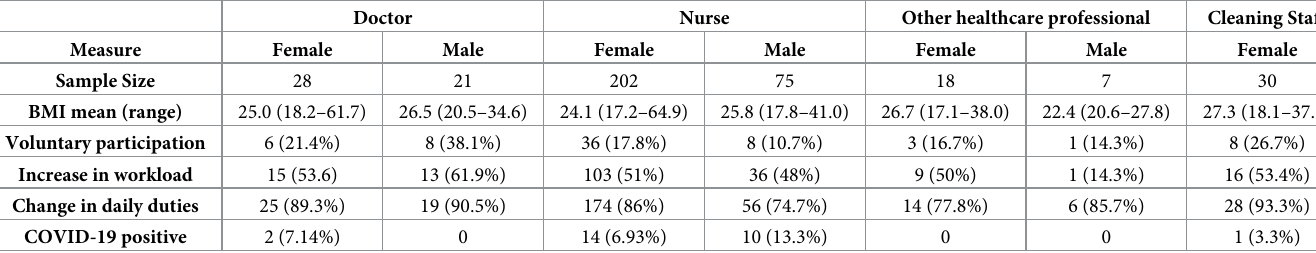
Table 1. Demographic data of the sample